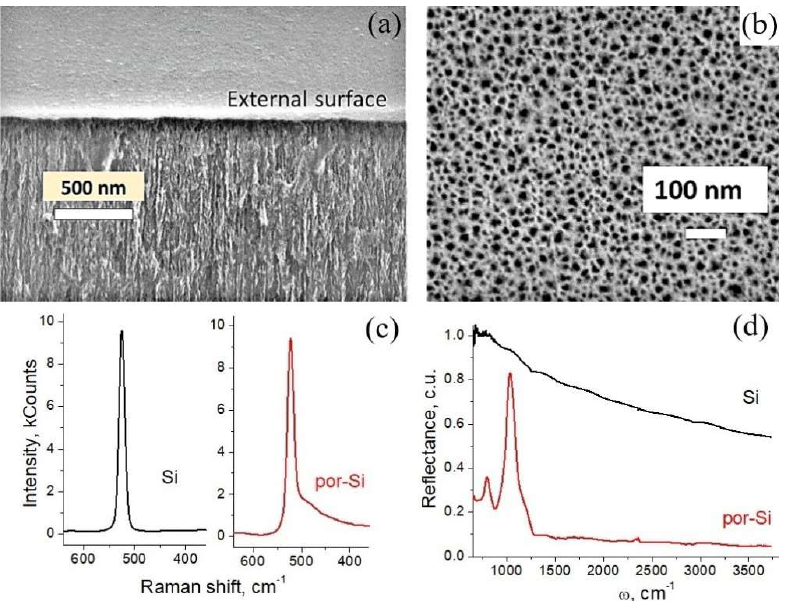
Figure 1. SEM images of por-Si layer: arbitrary cleavage ( a ) and top view ( b ). Raman ( c ) and IR ( d ) spectra of raw (black curve) and nanoporous (red curve) silicon.